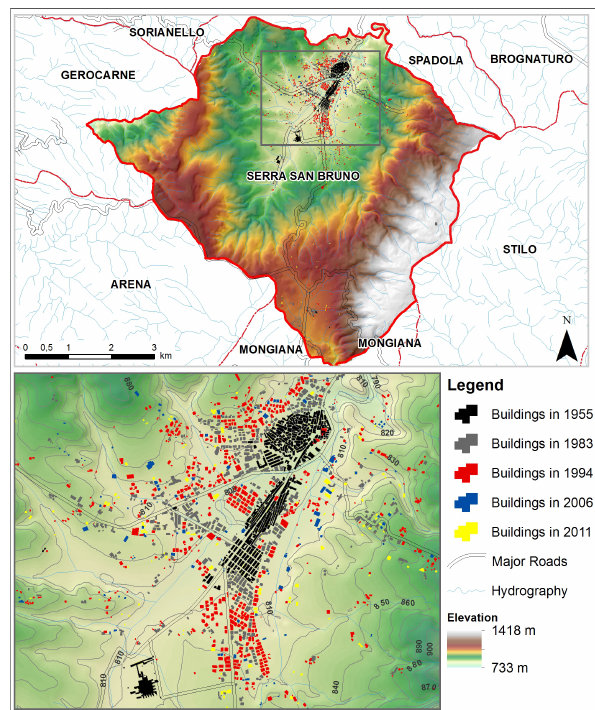
Fig. 11. Overview of the settlement expansion in the study area from 1955 to 2011 superimposed over the Digital Elevation Model